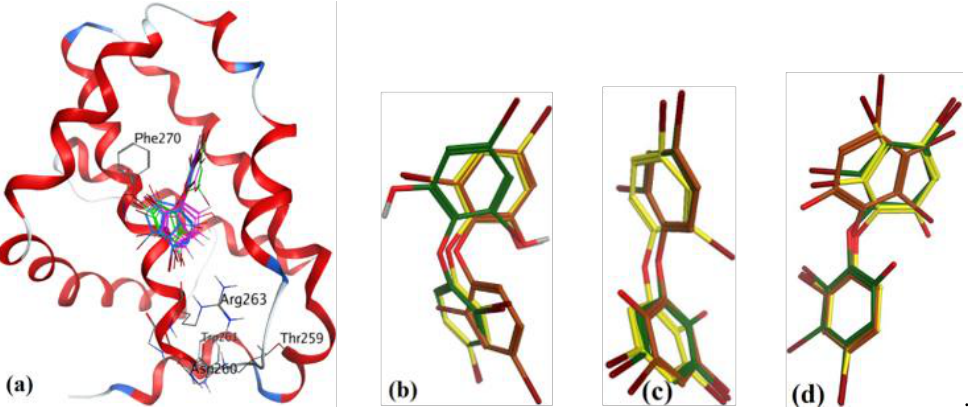
Figure 7. ( a ) Binding modes of diphenyl derivatives: 2a (magenta), 2b (Green), and 2c (Blue). ( b ) Docked poses of 2a from MOE (in brown), AutoDock (in Green), and VlifeDock (in yellow). ( c ) Docked poses of 2b from MOE (in brown), AutoDock (in Green), and VlifeDock (in yellow). ( d ) Docked poses of 2c from MOE (in brown), AutoDock (in Green), and VlifeDock (in yellow).